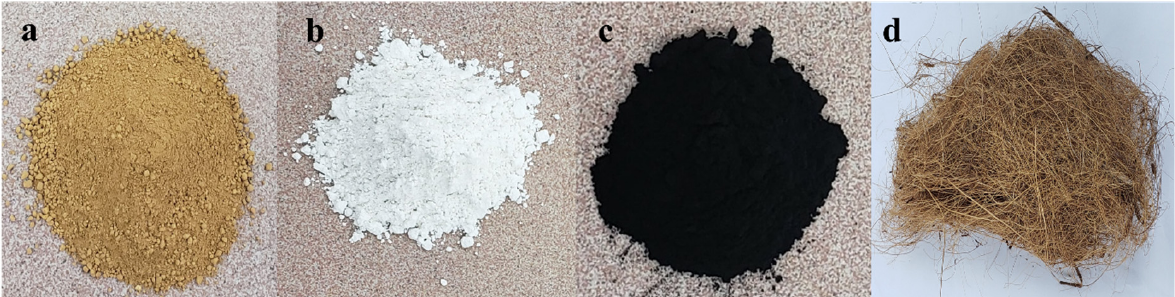
Figure 2. Image of ( a ) soil, ( b ) lime, ( c ) activated carbon, ( d ) coir